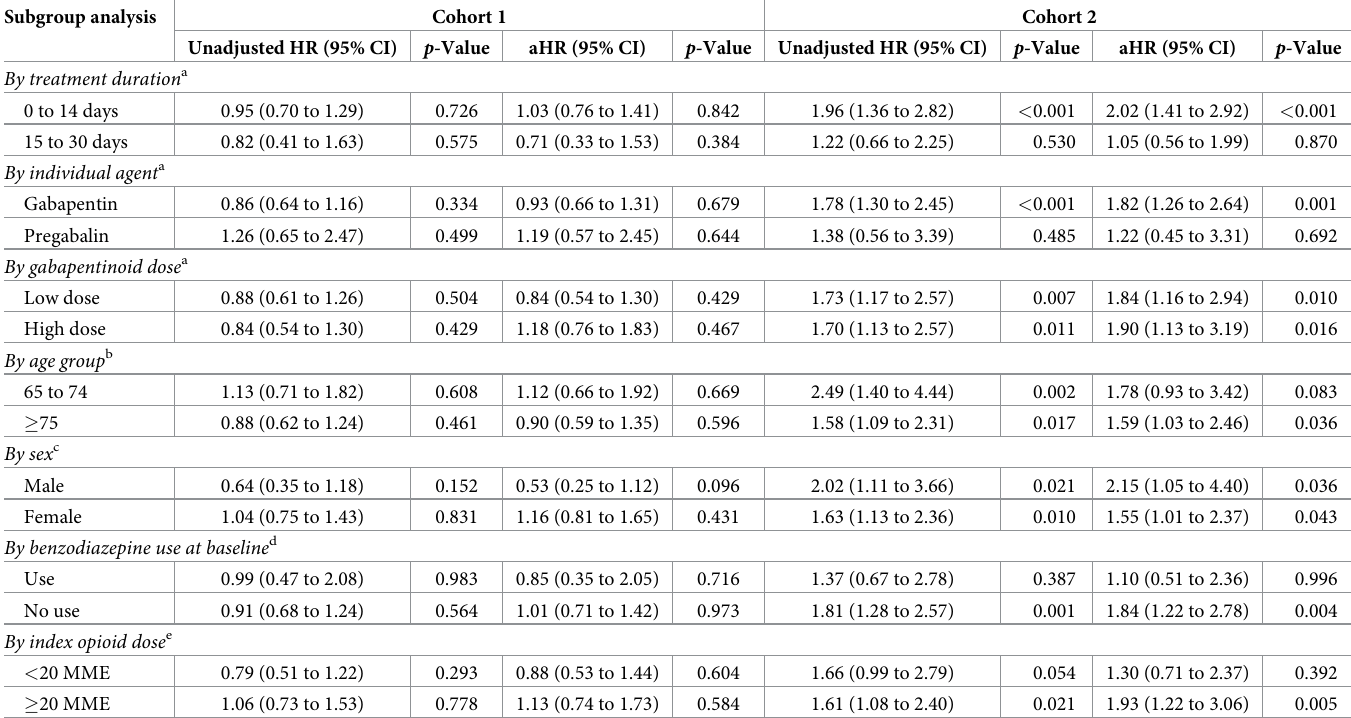
Table 4. Risk of fall-related injury comparing concurrent gabapentinoid–opioid users and opioid-only users among